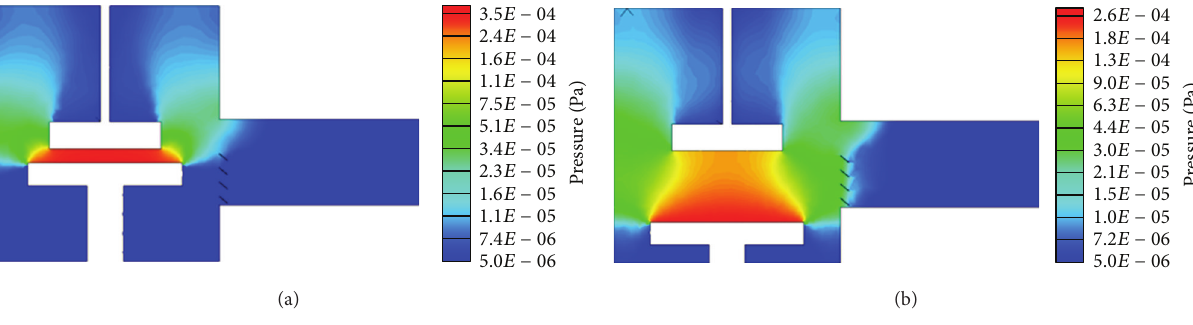
Figure 5: Pressure distribution diagrams with (a) 30 mm and (b) 150 mm T/S distance (slice from x - y plane).